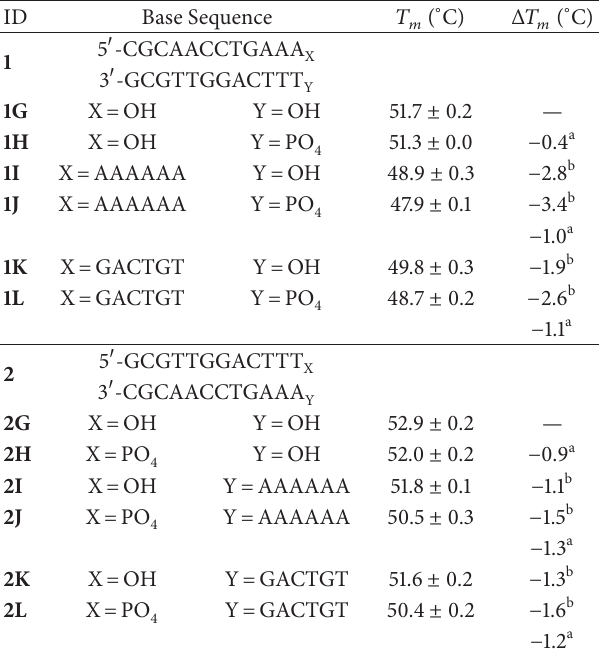
Table 2: Comparison of 𝑇 𝑚 values for replication relevant DNA architectures containing individual 3 󸀠 and 5 󸀠 overhangs, a terminal phosphate, and presence of both an overhang and phosphate. The ), hydroxyl (OH) and a 6 mer presence of a 3 󸀠 or 5 󸀠 phosphate (PO 4 overhang is indicated as an “X” or “Y” at the end of the core dsDNA sequences. Δ𝑇 𝑚 values were obtained by subtracting the 𝑇 𝑚 of each construct from the 𝑇 𝑚 value of the core